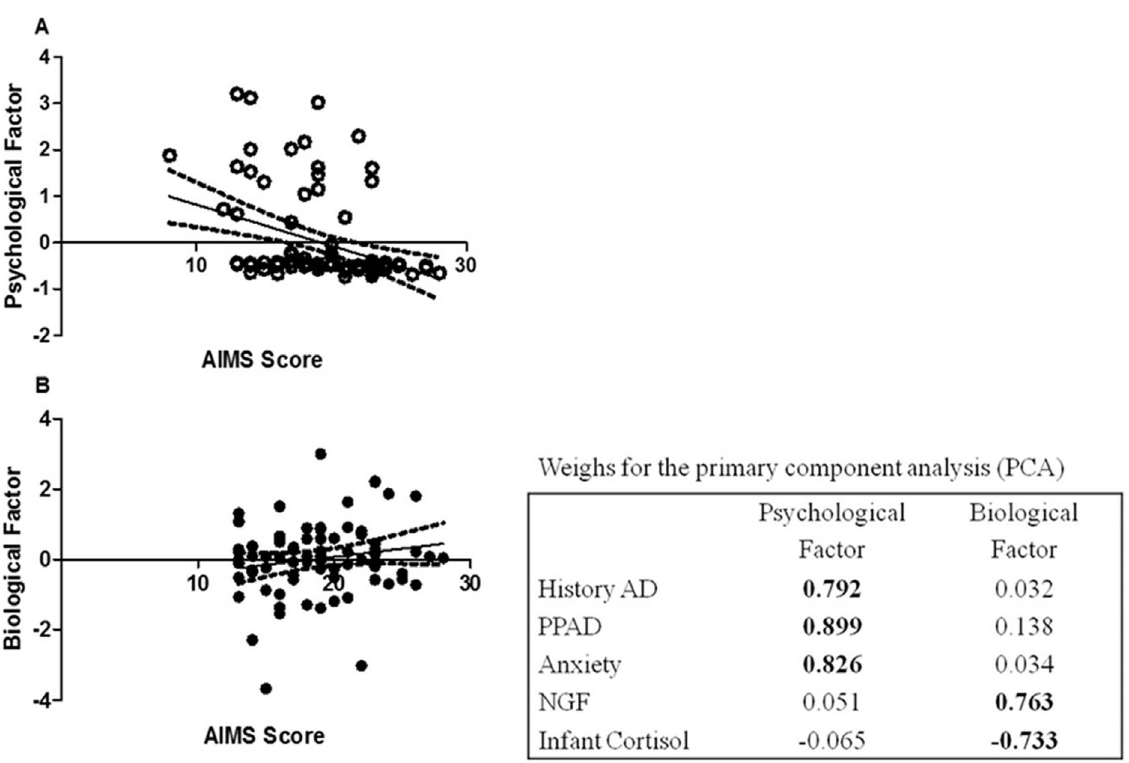
Figure 1. Primary component analysis (PCA) of psychological and biological factors in infants neurobiological-motor development according with Alberta Infant Motor Scale (AIMS). Panel A: Psychological factor including history of affective disorders (AD), postpartum affective disorders (PPAD), and anxiety influence in AIMS score. Panel B: Biological factor including maternal NGF levels and infant cortisol levels influence in AIMS score. The box shows the weight for each variable in psychological and biological component.